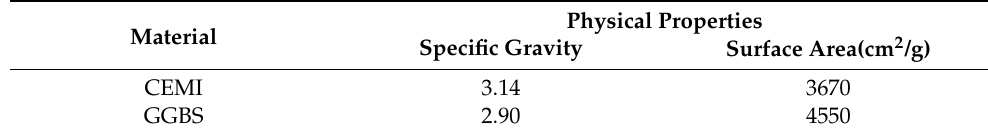
Table 18. Physical properties of Cement and GGBS [77].